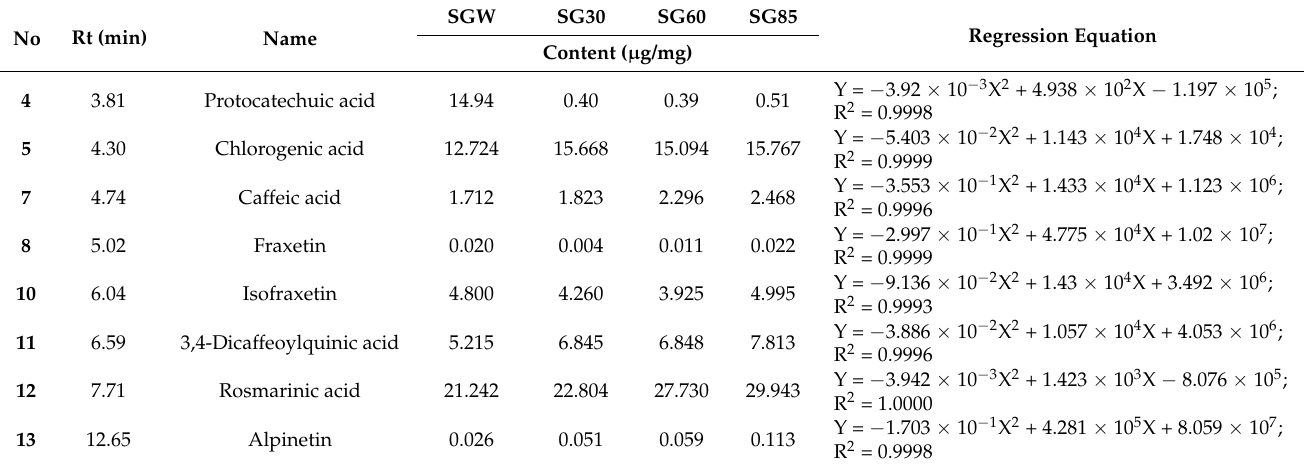
Table 7. The contents of main active ingredients in different SG